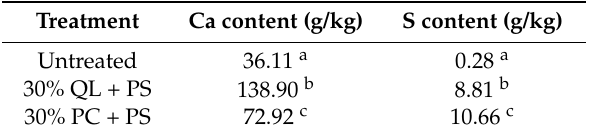
Table 4. Content of Ca and S before and after the experiments.